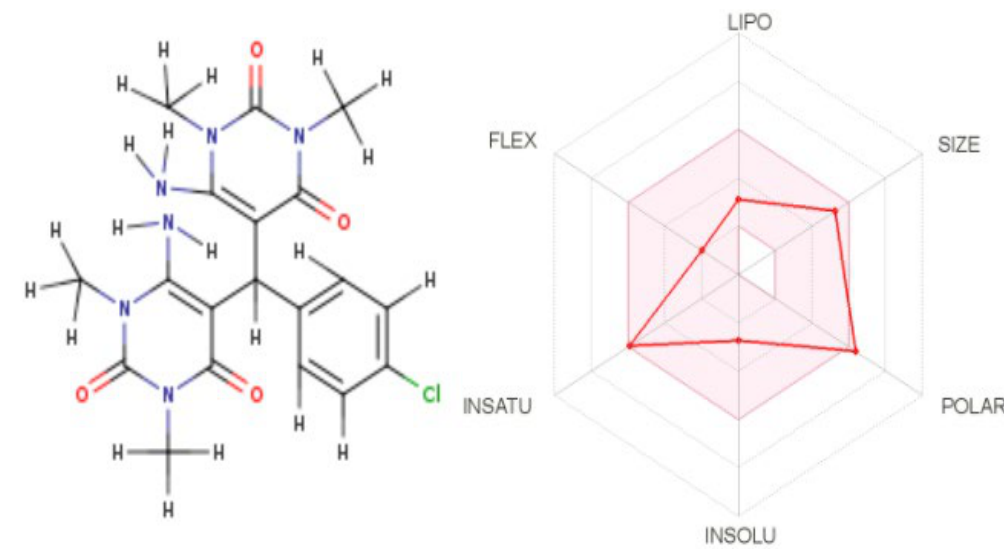
Figure 5. Bioavailability radar depiction of the two-dimensional molecular structure.